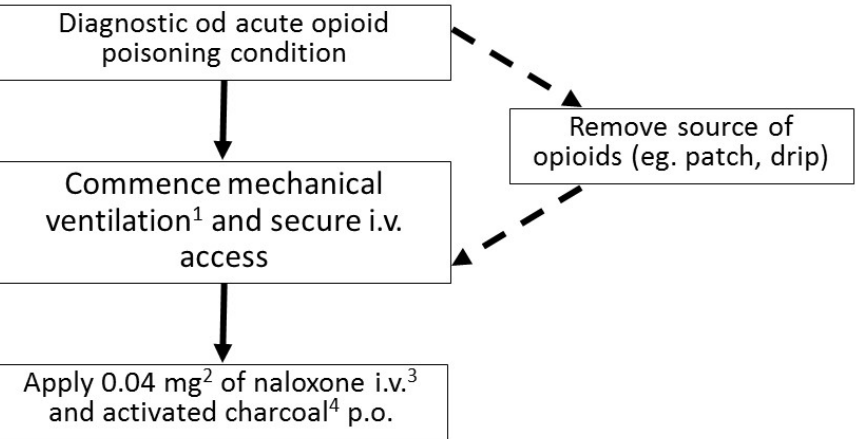
Figure 2. Flowchart describing the management of acute opioid poisoning in an adult ( 1 Most commonly noninvasive; if the GCS < 8 endotracheal intubation is indicated. 2 If no improvement occurs after 2–3 min the dose can be increased first to 0.5 mg, then, after another 2–3 min, to 2 mg, then to 4 mg, 10 mg, and up to the maximum dose of 15 mg. 3 If securing an i.v. access is impossible, naloxone can be administered i.m. or intranasally. 4 Recommended in absence of